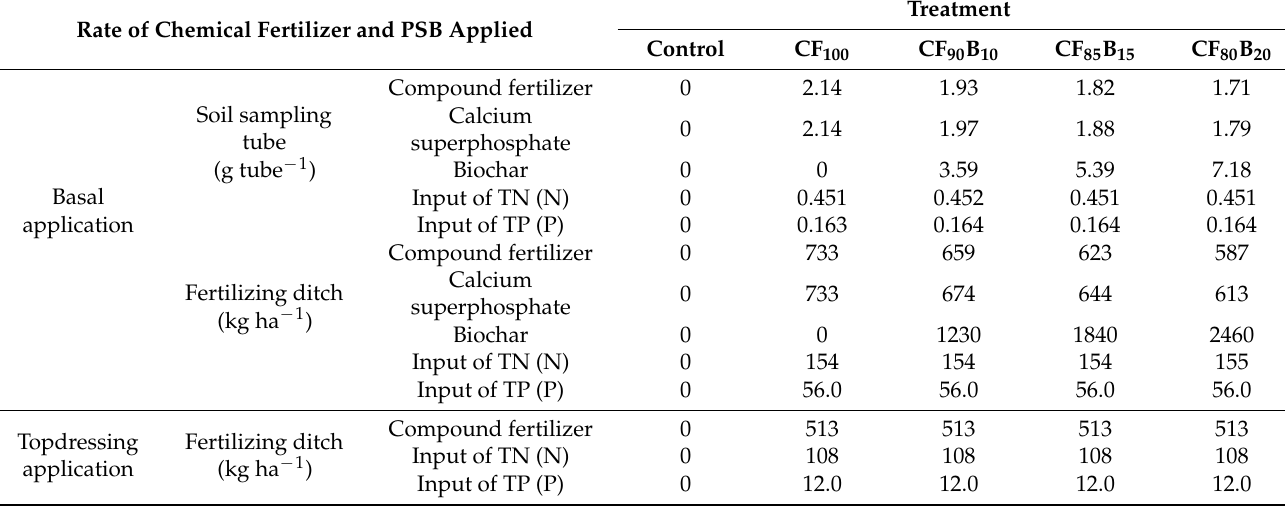
Table 3. Treatments with different rates (dry basis) of chemical fertilizer and palm silk biochar (PSB) applied. Rate of Chemical Fertilizer and PSB Applied